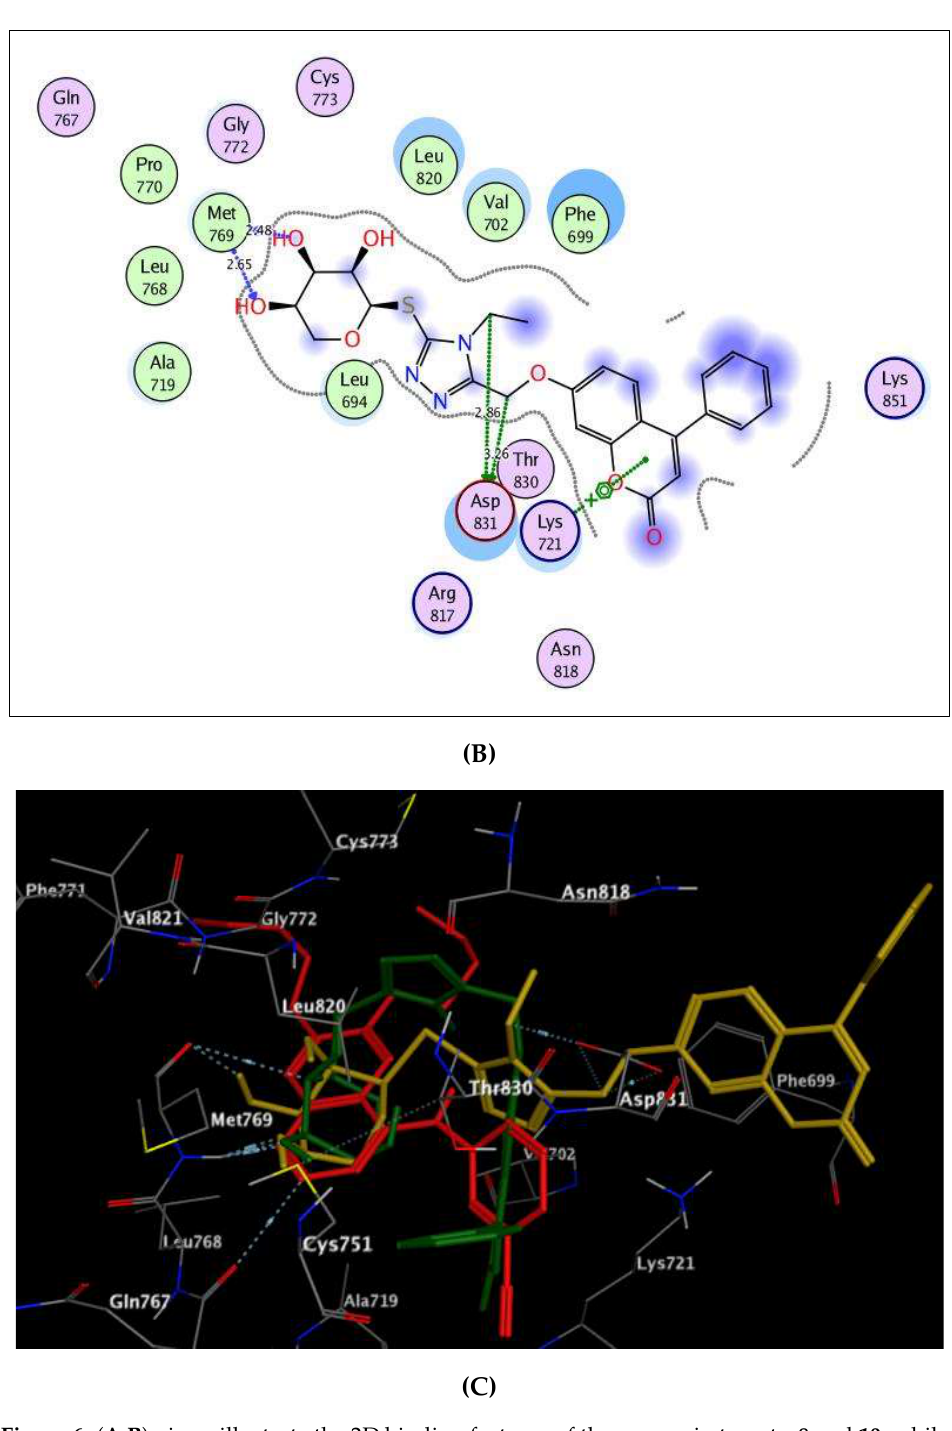
Figure 6. ( A–B ) views illustrate the 2D binding features of the coumarin targets, 8 and 10, while ( C ) view illustrates the 3D superimposition between original ligand erlotinib (red), 8 (green) and 10 (yellow) within the active site of EGFR (PDB code: 1M17), respectively.